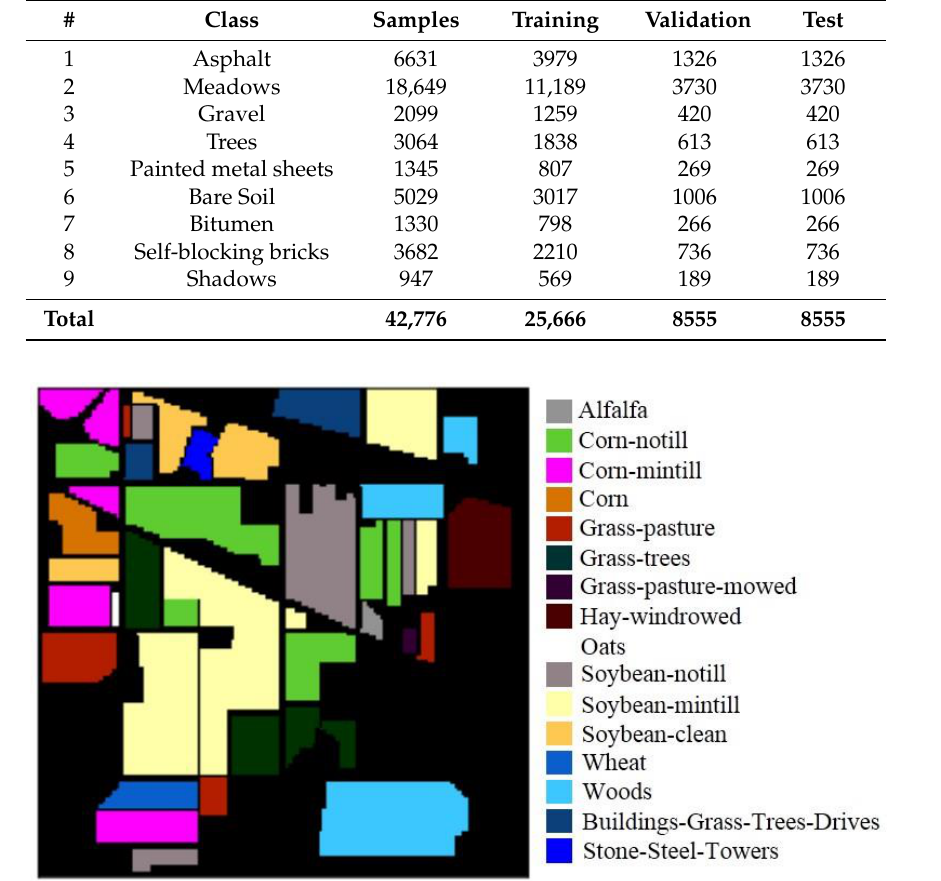
Figure 4. Indian Pines representing 16 classes. Table 2. Land cover classes and numbers in Indian Pines.